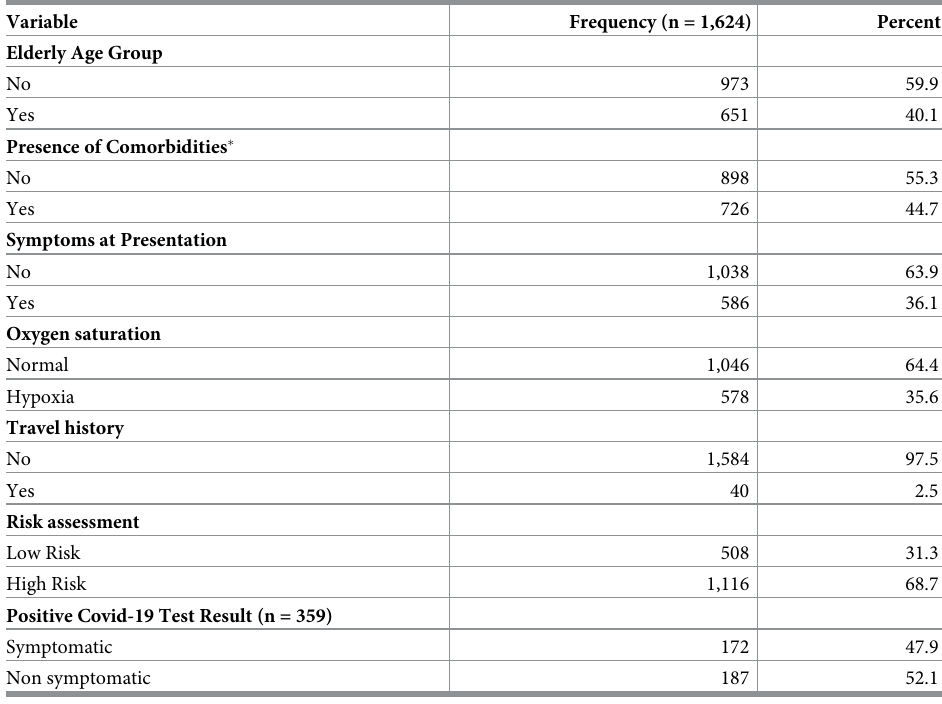
Table 2. Risk assessment for COVID-19 at A&E point of entry and test result.